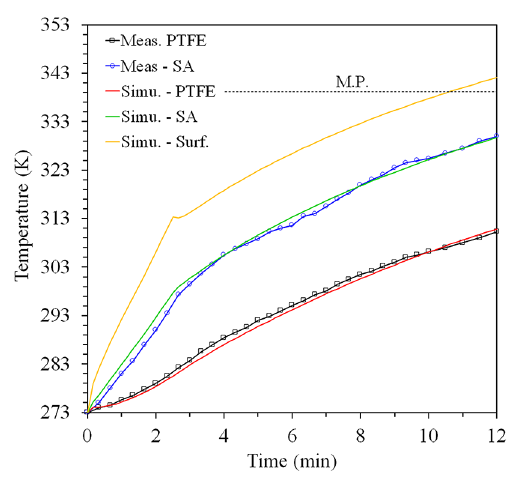
Figure 7. Experimental and simulated temperature with two thermocouples on front position with onset at 273 K. The dot line represents the melting temperature of sample